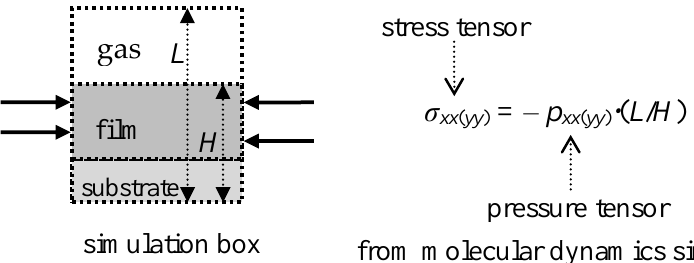
Figure 1. Calculation of the stress tensor components. Solid black arrows indicate external forces applied to keep the volume constant in the case of compressive stress. L and H are the vertical dimensions of the simulation box and film thickness, respectively.